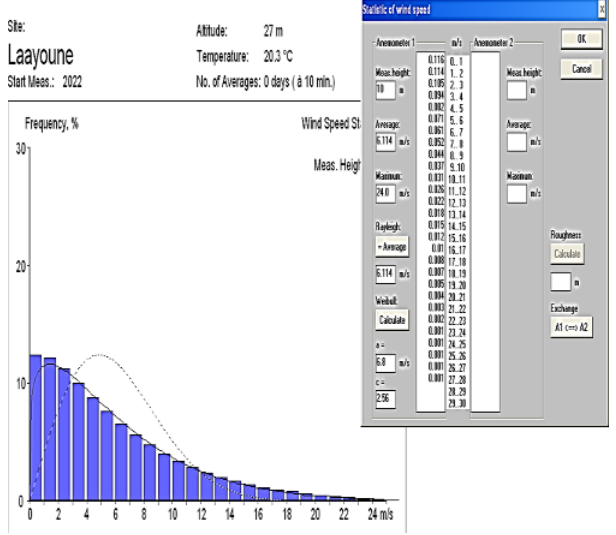
Fig. 1. Wind potential of the site of Laayoune.